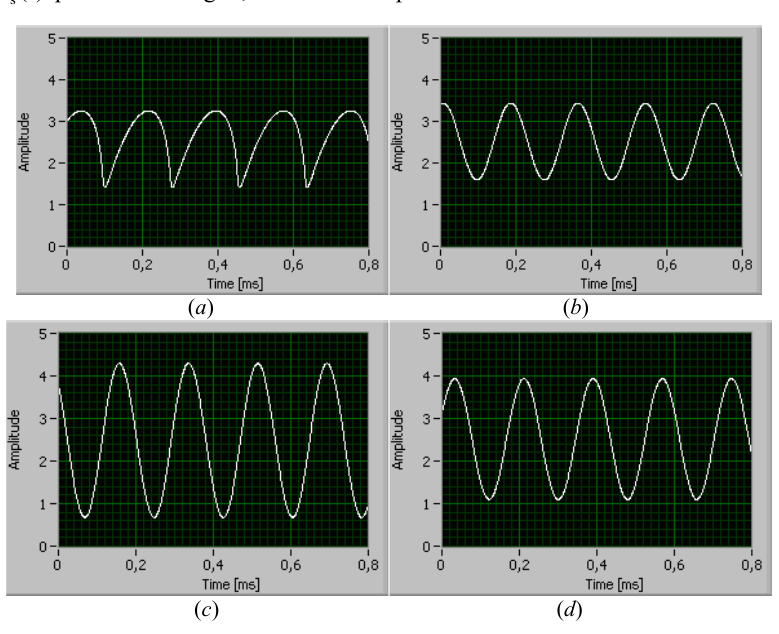
Fig. 3. Oscillograms of SAD signals synchronisation ( a ); and if available for cases where